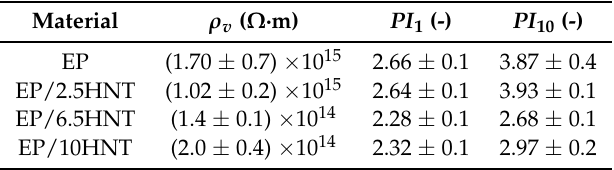
Table 2. Dielectric parameters estimated from the absorption current.